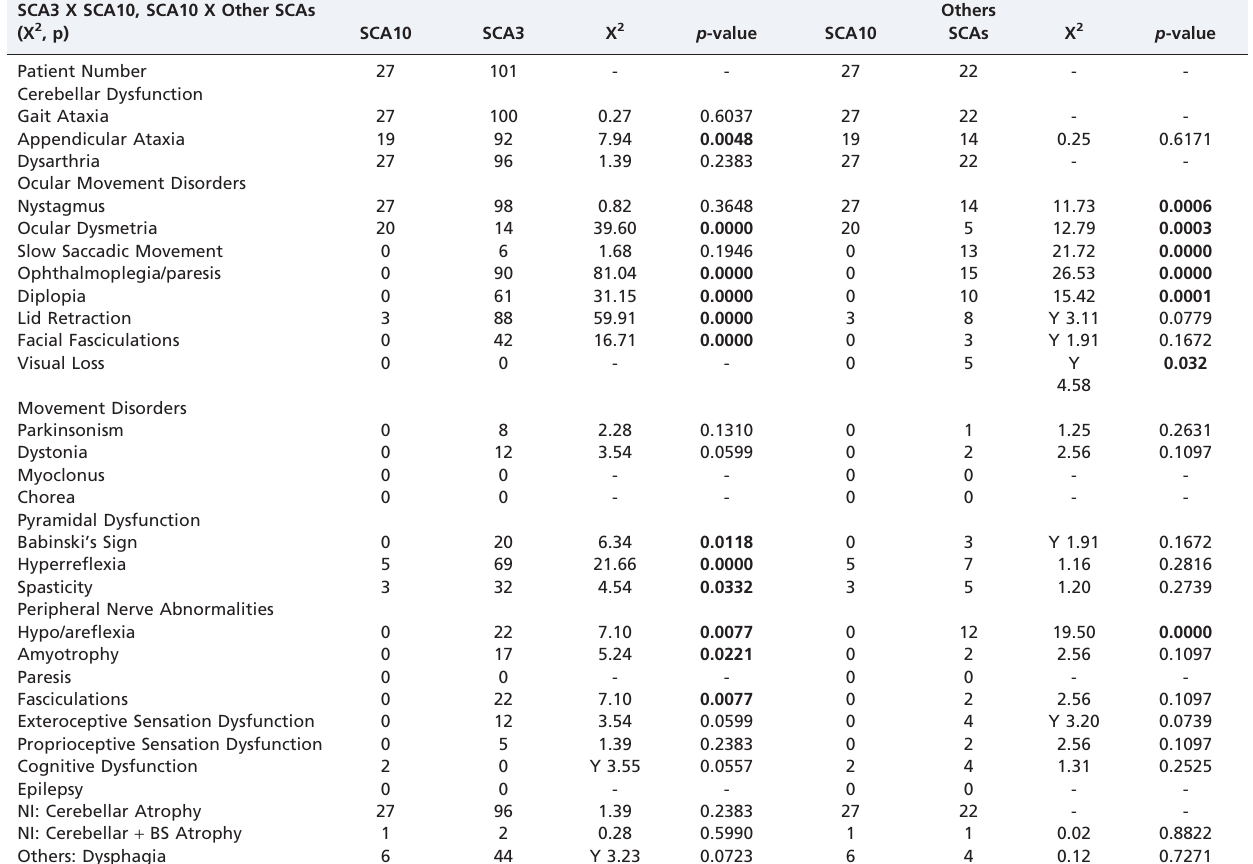
Table 2 - A comparative statistical analysis between the clinical data and neuroimaging results of patients with SCA3 x SCA10 and SCA10 x other SCAs.